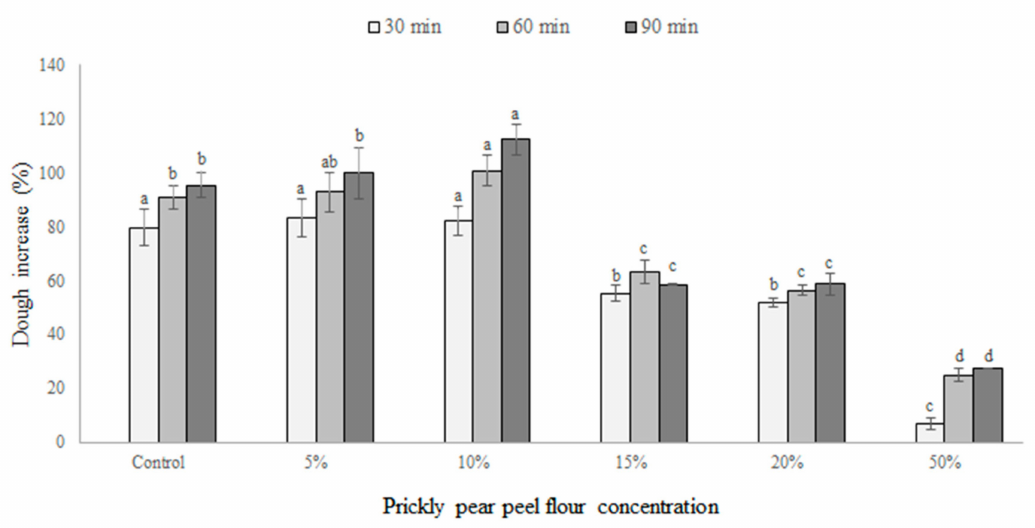
Figure 2. Leavening capacity of doughs added with di ff erent prickly pear flour concentrations and evaluated after 30, 60 and 90 min of incubation at 30 ± 1 ◦ C. Columns at the same incubation time (30, 60 or 90 min) followed by di ff erent letters are significantly di ff erent according to Fisher’s least significant di ff erence test ( p < 0.05). Vertical bars indicate the standard deviation of the